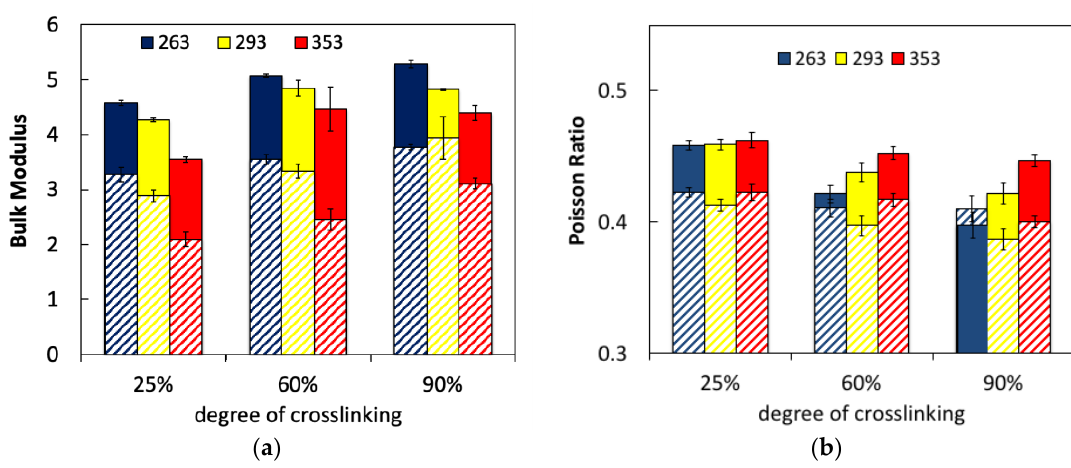
Figure 7. Molecular dynamics results of the effect of the temperature at three chosen degrees of crosslinking on the ( a ) bulk modulus calculated from compression at a rate of 10 7 s −1 (striped bars) and fluctuations (solid bars) and ( b ) Poisson’s ratio calculated from Equation (2) based on tensile deformation rates of 10 7 s −1 (solid bars) and 10 9 s −1 (striped bars).